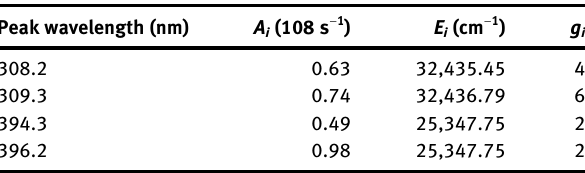
Table  : Spectroscopic parameters of aluminum atomic lines used in the Boltzmann plot